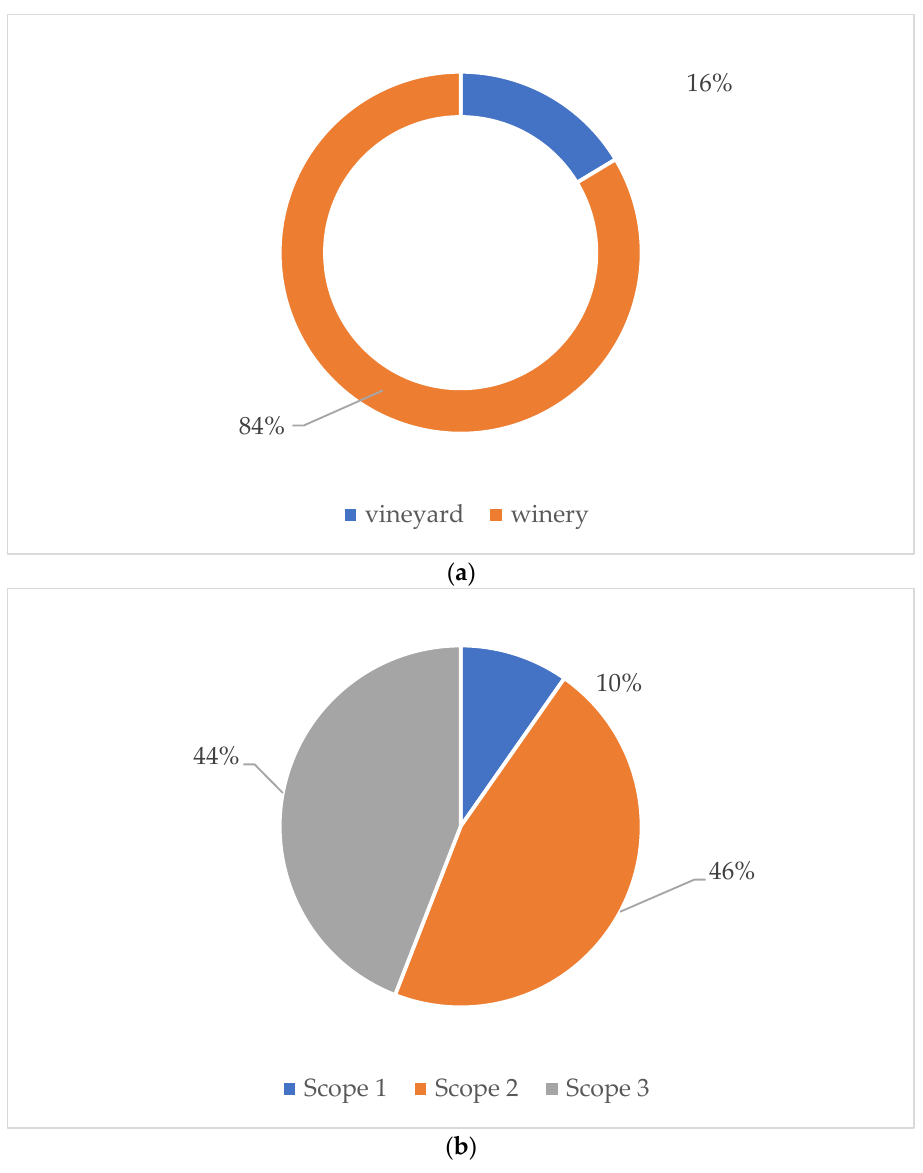
Figure 2. ( a ) Contribution of the vineyard and the winery to the total emissions (total = 99,586 kg CO 2 -eq). ( b ) Emissions per scope category. Scope 1: emissions controlled by the winery (9685 kg CO 2 -eq); Scope 2: electricity purchase from the national network (45,993 kg CO 2 -eq) and Scope 3: factors controlled by others (e.g., vinegrowers, waste management—(43,908 kg CO 2 -eq)).